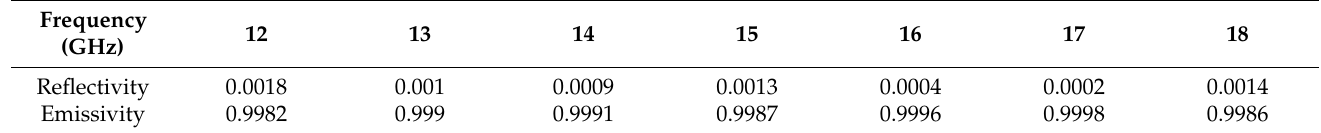
Table 2. The electromagnetic test results of the blackbody calibration target.